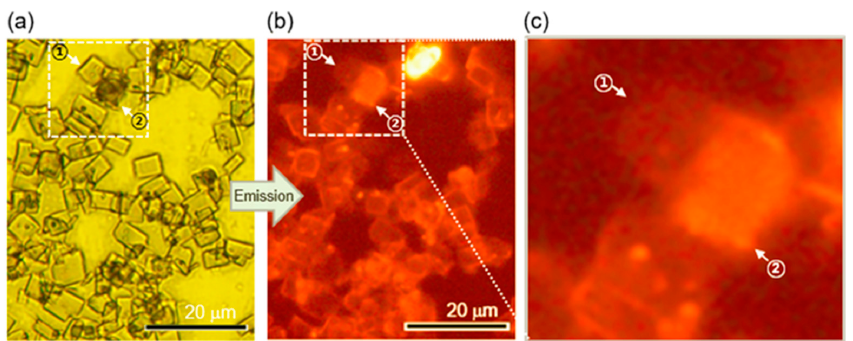
Figure 4. ( a ) OM and corresponding ( b ) FOM images of rectangular microstructures acquired from 920 μ M DMF ‐ H 2 O (6/0.5, v / v ) ( c ) The magnified image of the selected area in ( b ). 920 µ M DMF-H 2 O (6/0.5, v / v ) ( c ) The magnified image of the selected area in ( b